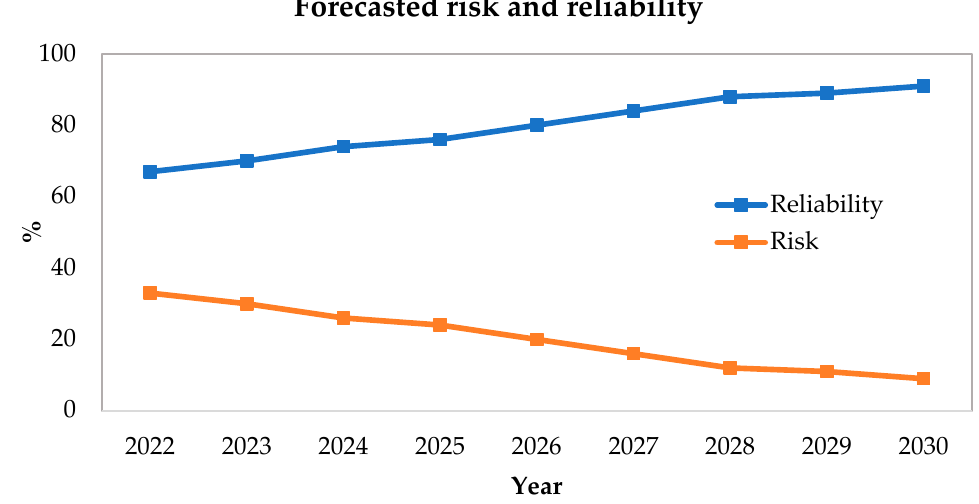
Figure 11. Dynamic risk probability of the MIC WWTP for the future period (2022–2030).